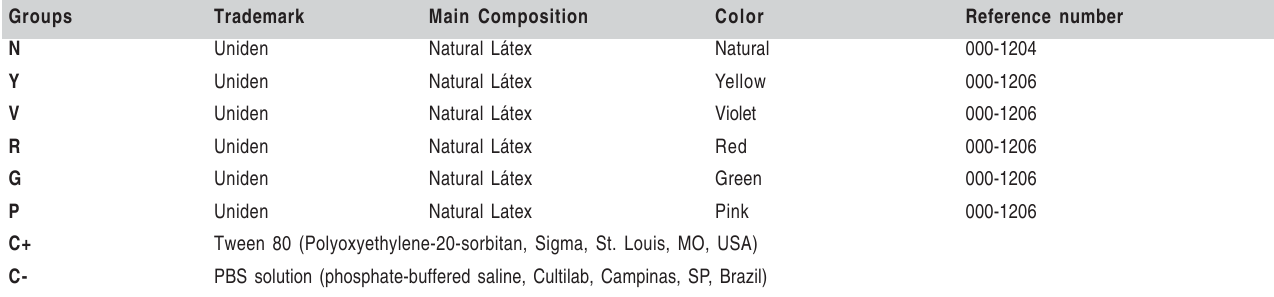
Table 1. Elastic and control groups used for the assays.